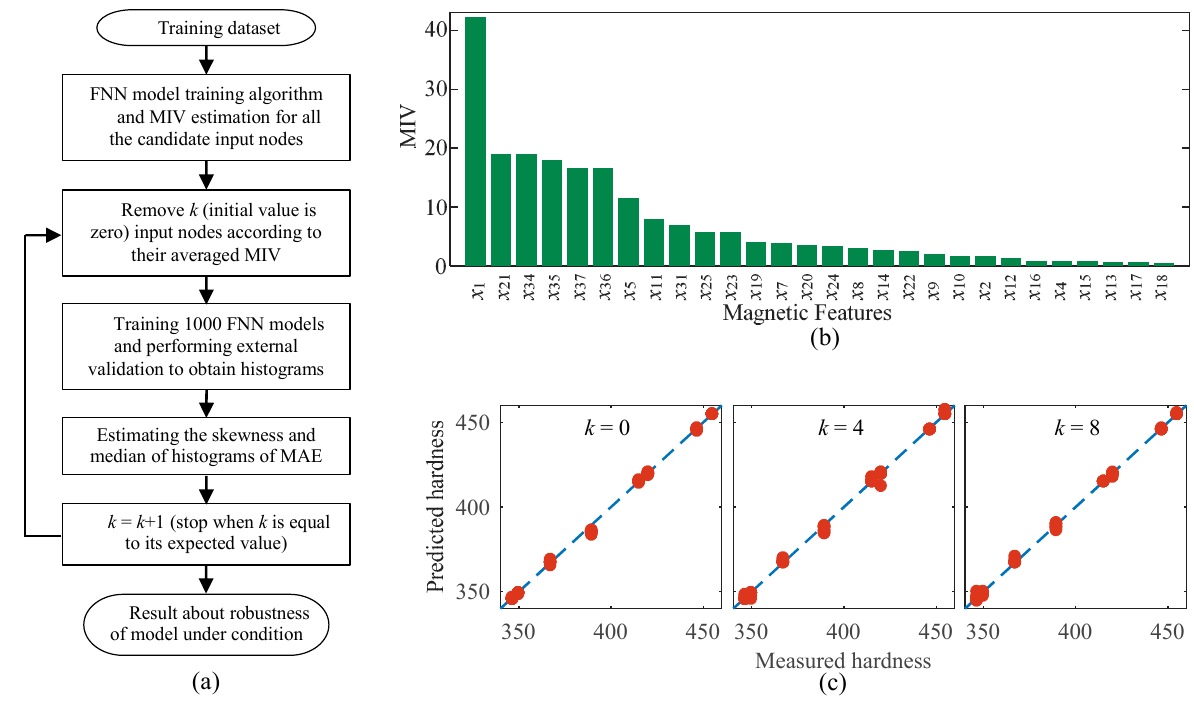
Figure 9. ( a ) Flow chart for the robustness evaluation of established models. ( b , c ) Magnetic features sorted by their estimated MIV values and performances of typical FNN models, respectively.